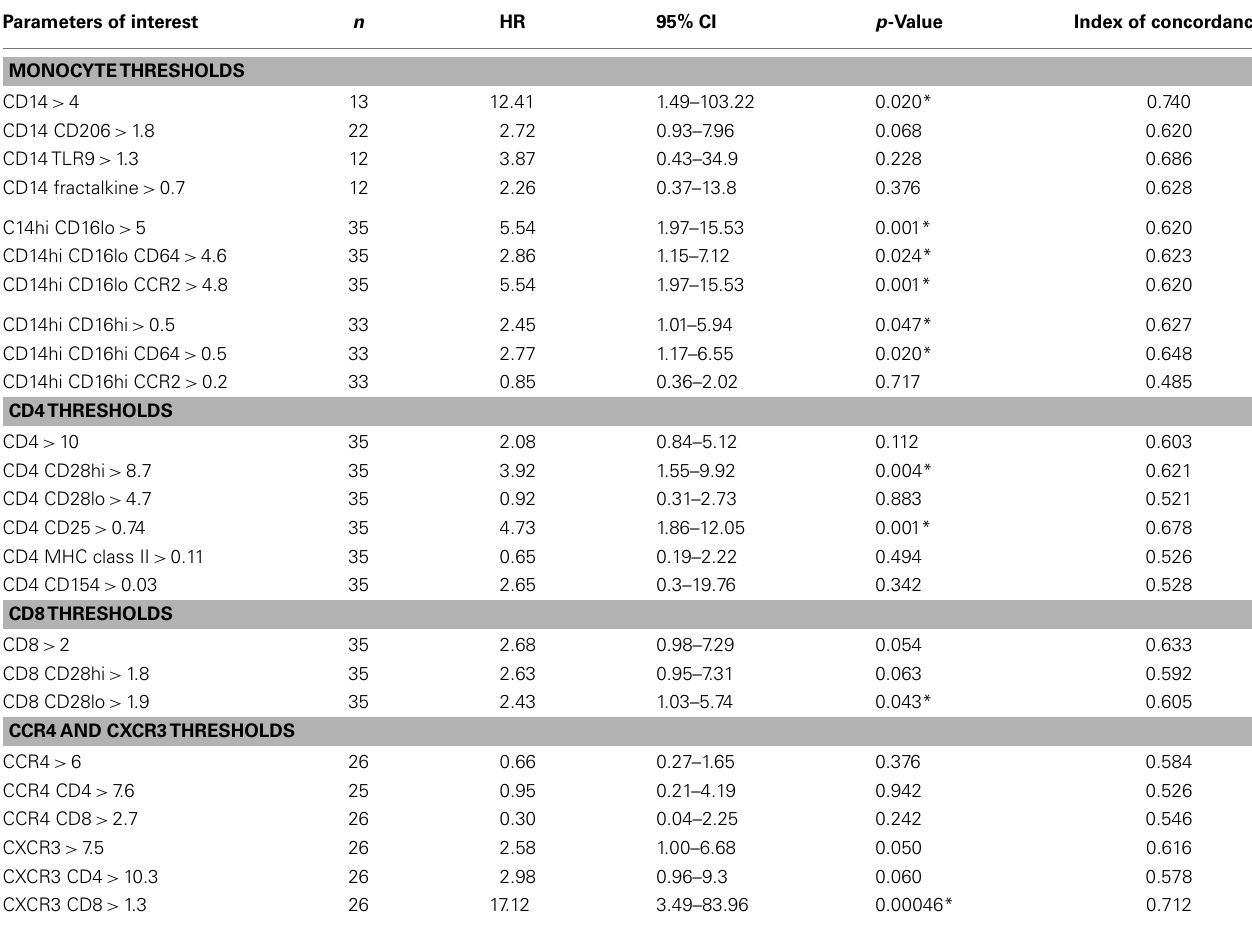
Table 3 | Univariate threshold-based analyses of biomarker levels and association between reaching the combined endpoint . Parameters of